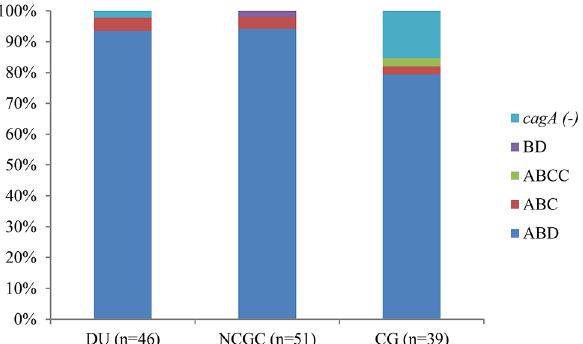
Figure 2. Distribution of cagA -EPIYA motifs in three clinical outcomes: duodenal ulcer (DU), non-cardia gastric cancer (NCGC), and chronic gastritis (CG). The EPIYA motifs of cagA included ABD, BD, ABC, and